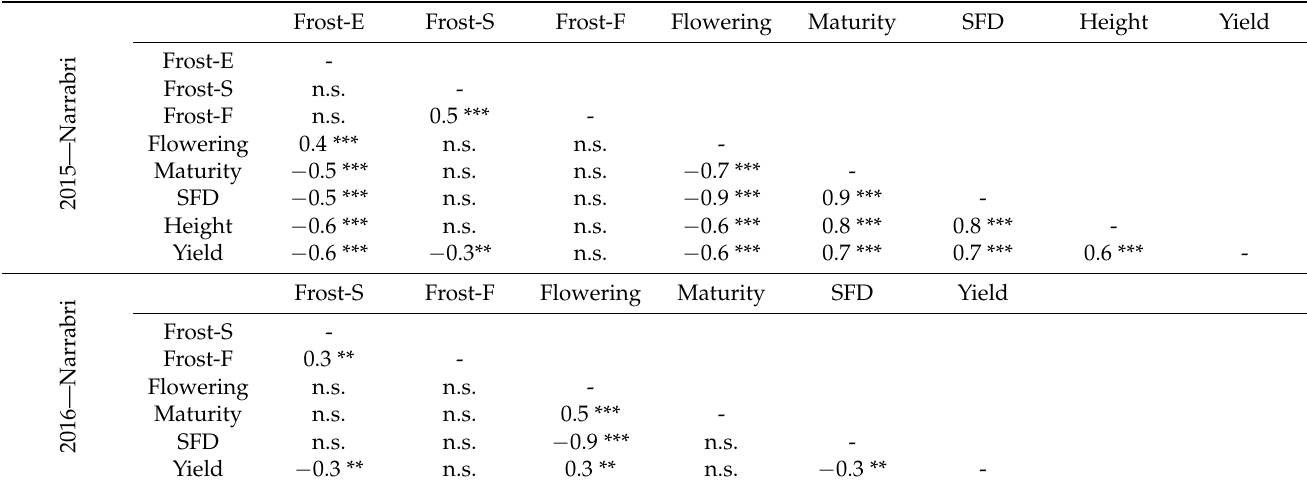
Table 4. Pearson correlation coefficients of frost damage in relation to seedling stage (Frost-E), stems (Frost-S), and flowers (Frost-F), with phenology, plant height at 50% physiological maturity, and yield, in 2015 and 2016, at the University of Sydney at Narrabri ( n =